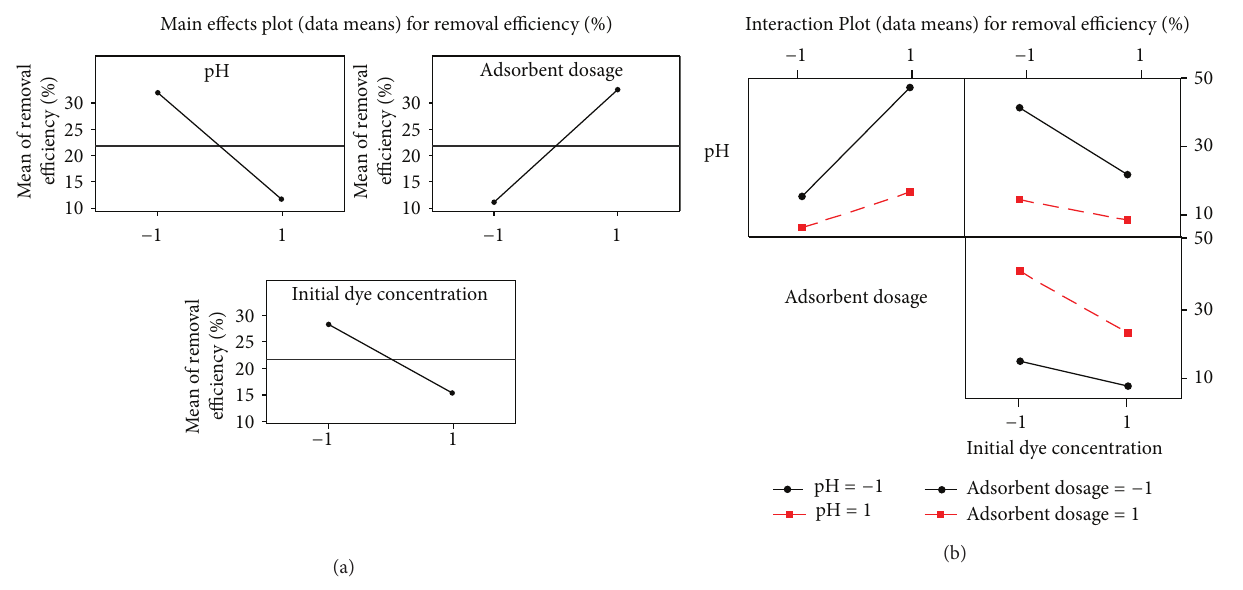
Figure 8: Plots of (a) main effects and (b) interaction effects for the removal efficiency (%). Table 5: Design matrix for Remazol